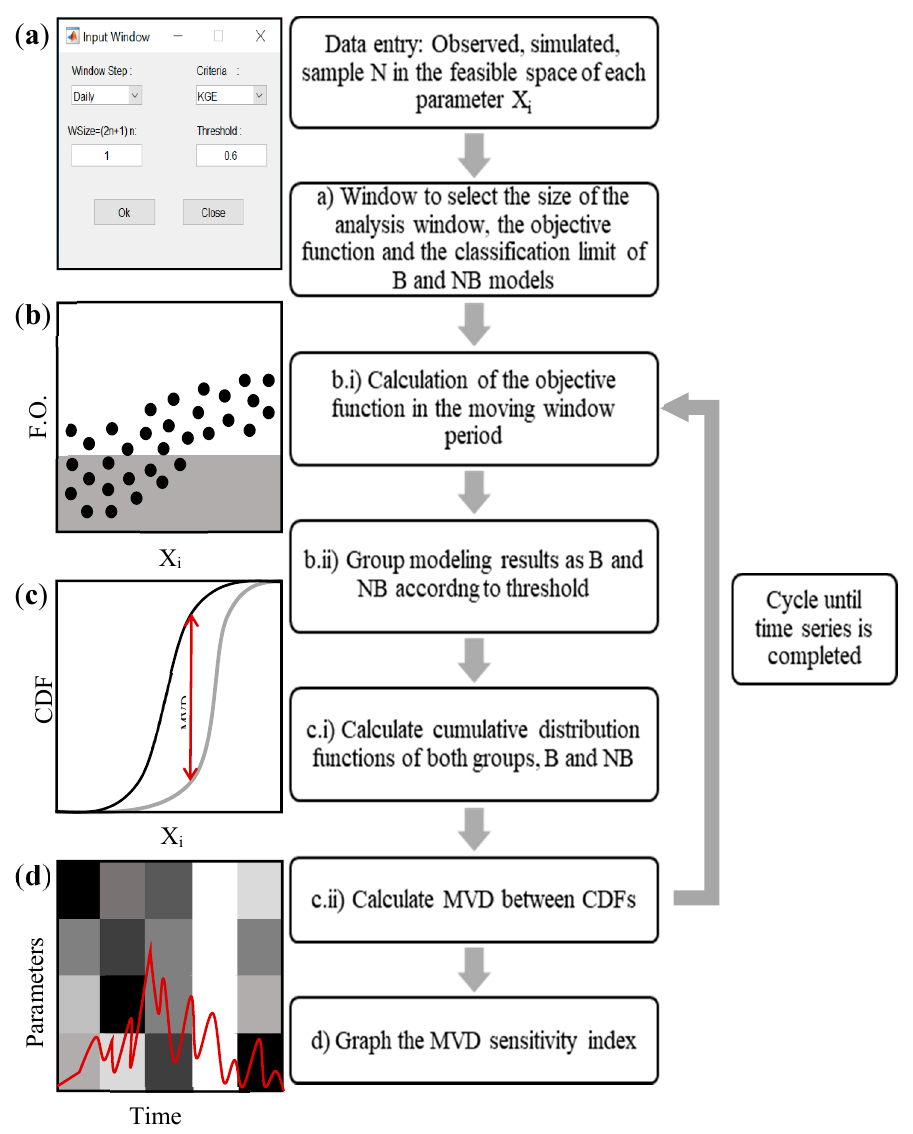
Figure 1. Code flow diagram. ( a ) Input window. ( b ) Objective function values. ( c ) Cumulative distribution functions of B and NB groups. ( d ) Graph of the MVD index at each window.